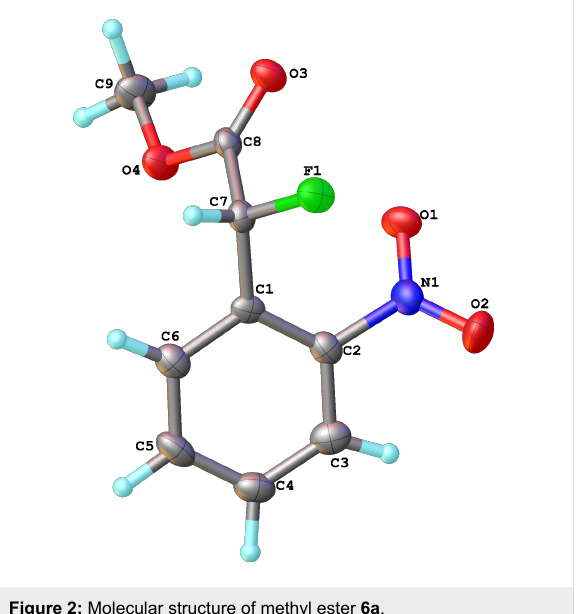
Figure 2: Molecular structure of methyl ester 6a